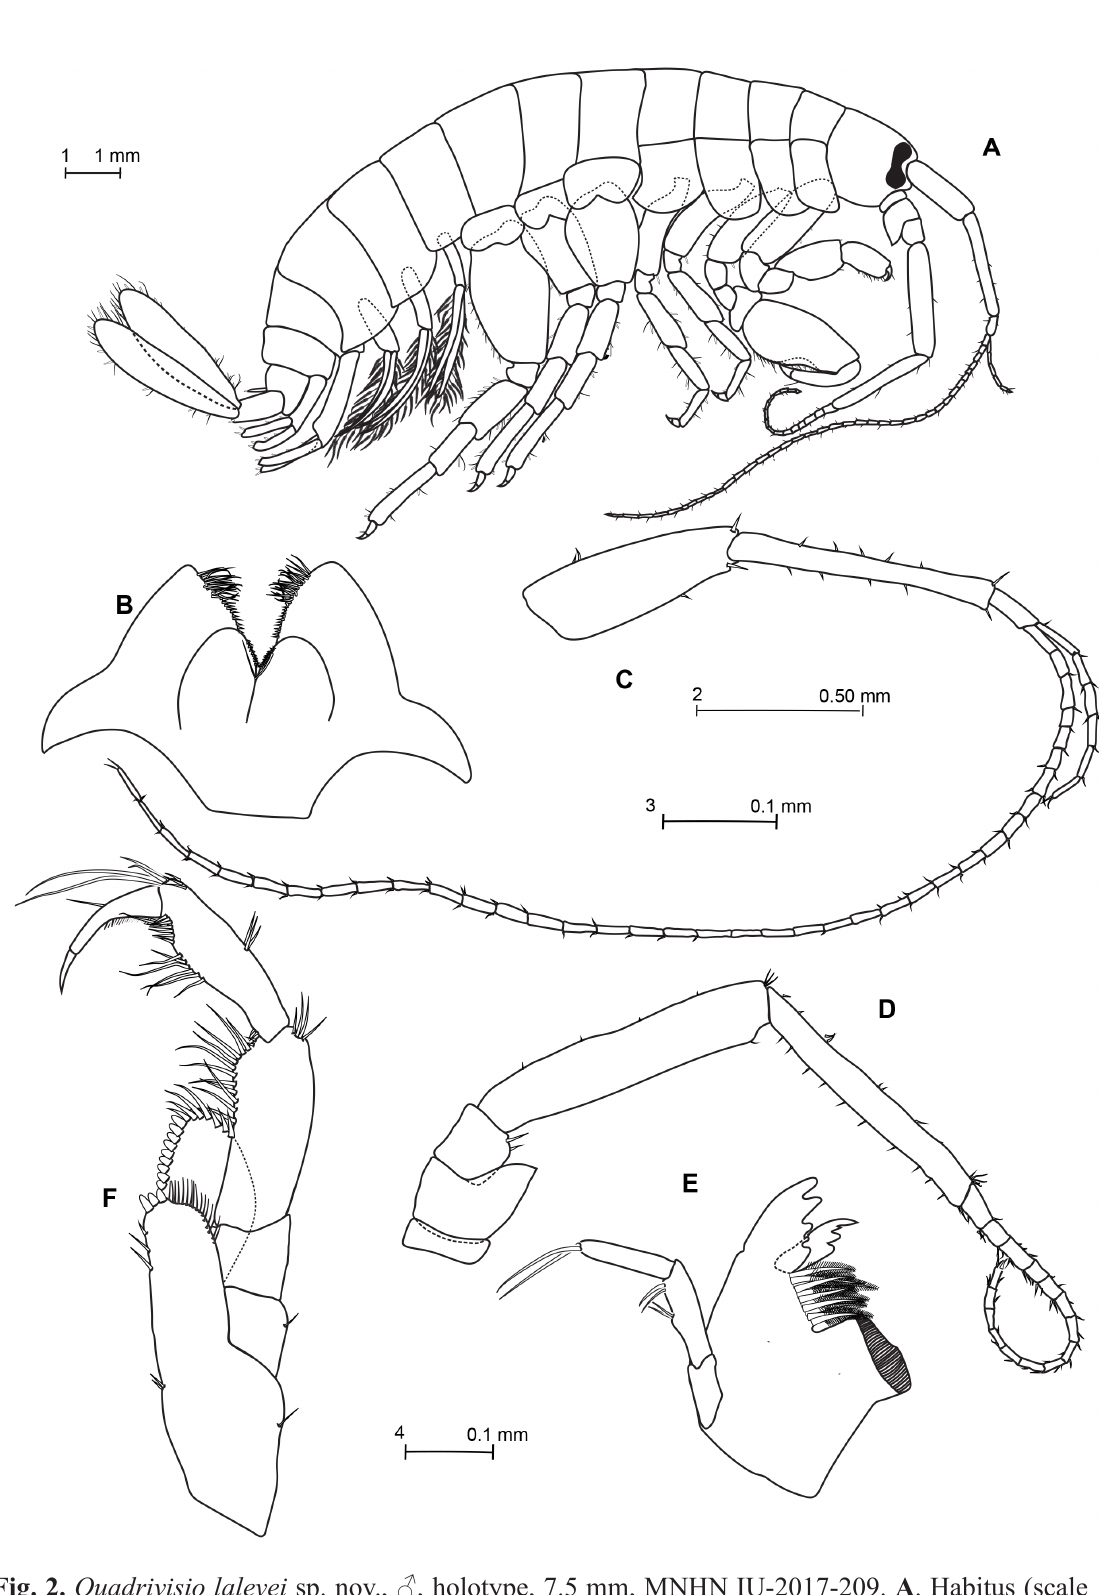
Fig. 2. Quadrivisio laleyei sp. nov., ♂, holotype, 7.5 mm, MNHN IU-2017-209. A . Habitus (scale 1). B . Lower lip (scale 3). C . First antenna (scale 2). D . Second antenna (scale 2). E . Left mandible (scale 4). F . Maxilliped palp (scale